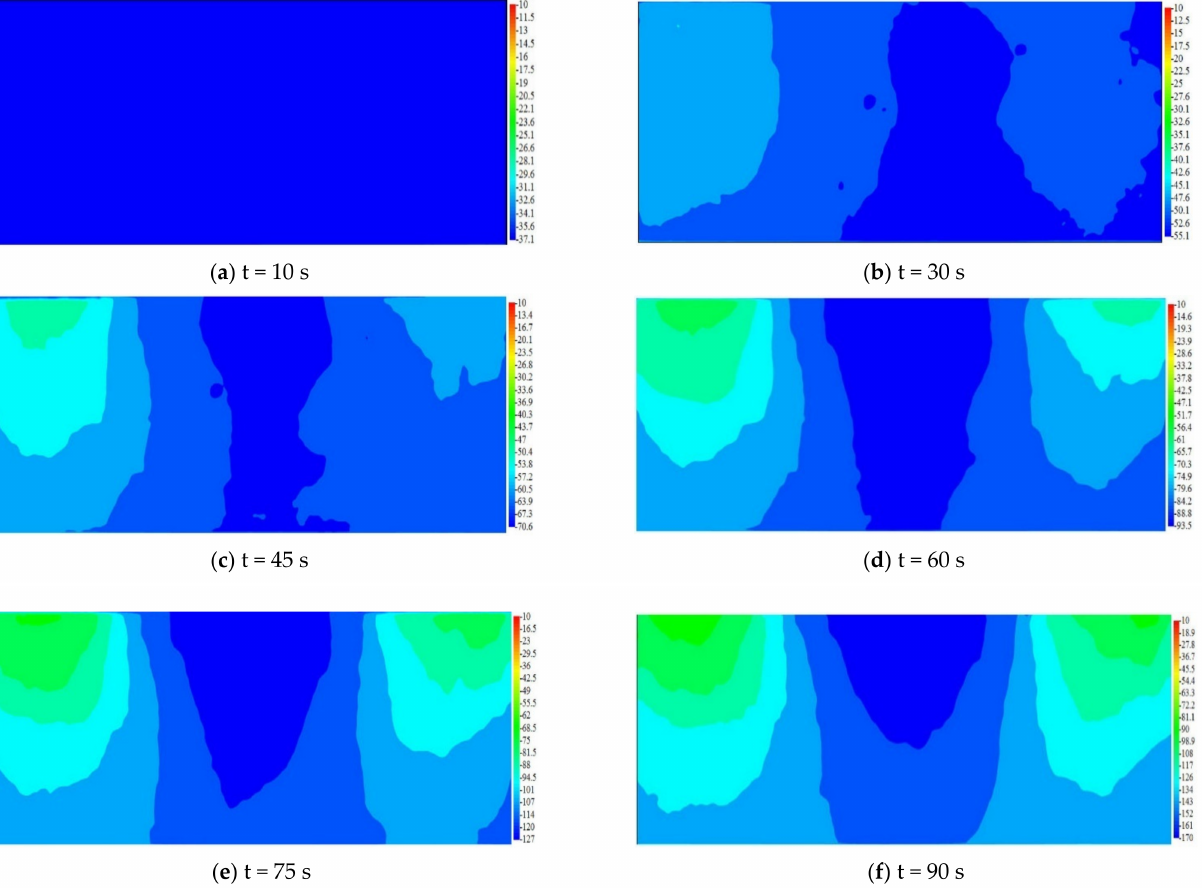
Figure 3. Displacement nephograms in the Y direction at different